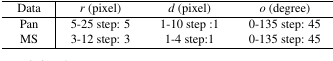
Table 2: GLCM parameter range values appropriate GLCM parameters to use for our data, we chose to explore a wide range of parameter values. The first order features were calculated using the same window radius values.